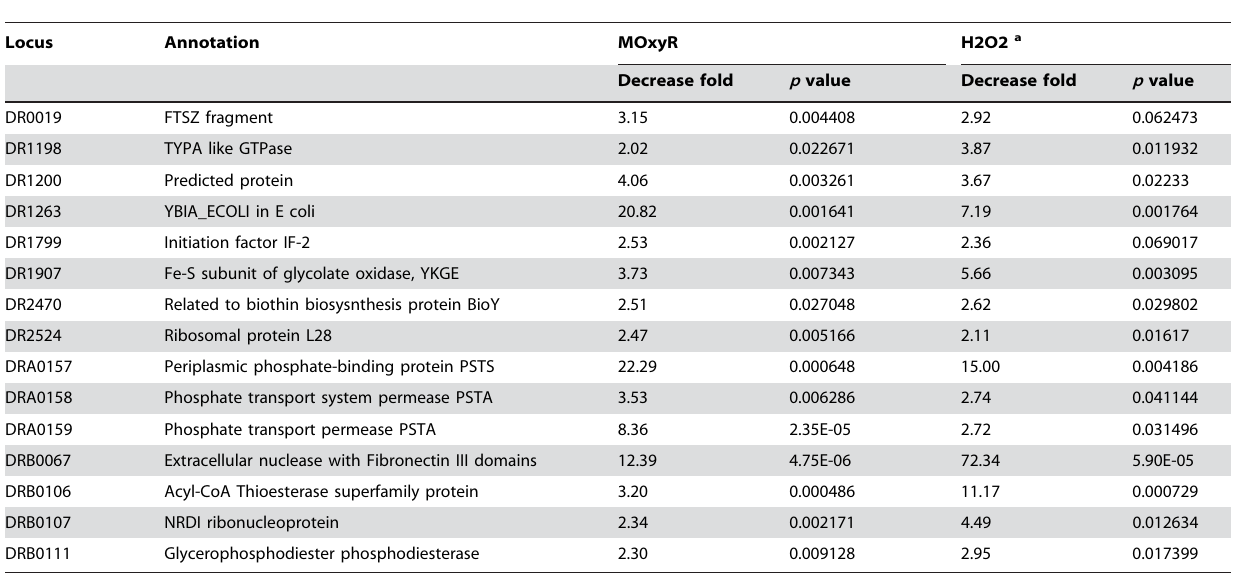
Table 6. Genes with a decreased level of expression both in wild-type strains treated with H 2 O 2 (20 mM) and in MOxyR.